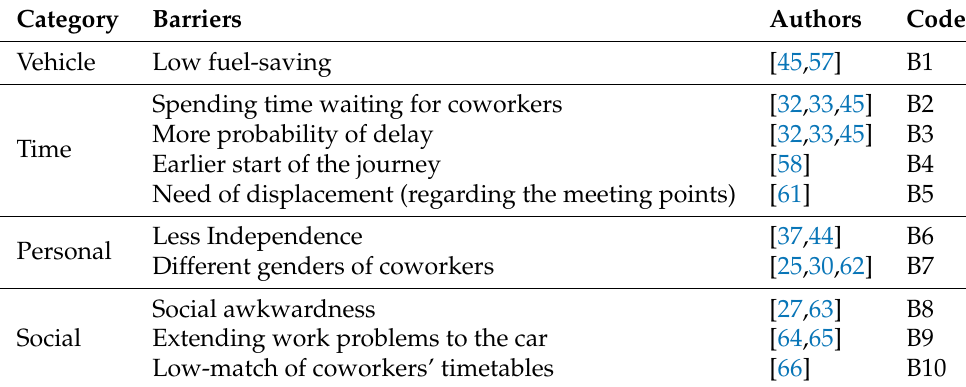
Table 4. Barriers to adopting carpooling for